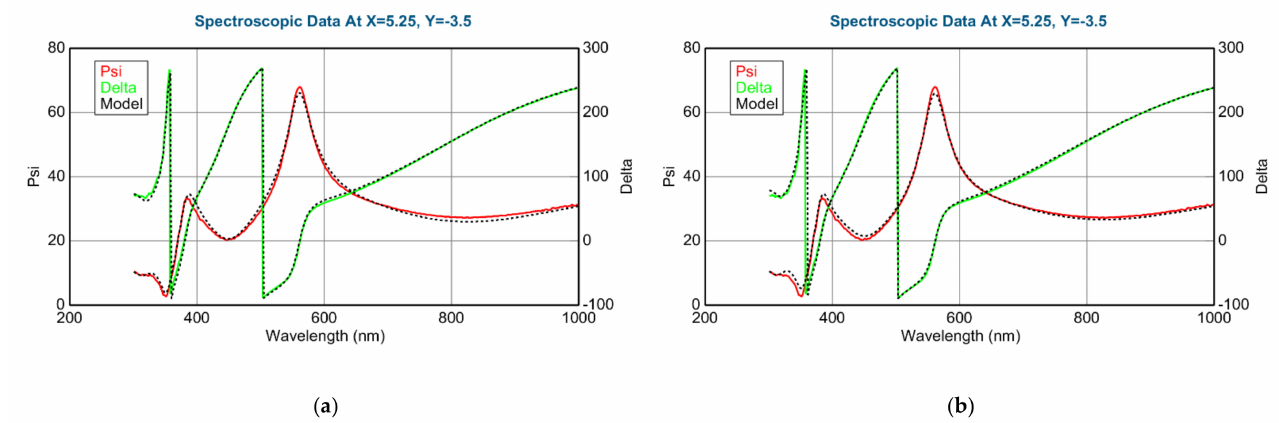
Figure 18. Amplitude-of-T-L (only WO 3 )–map ( a ) and EMA% (MoO 3 )–map ( b ). Red ellipses show the interesting area, where the composition changes the most. We show only one 15 × 15 cm part, all other parts show the same tendencies.